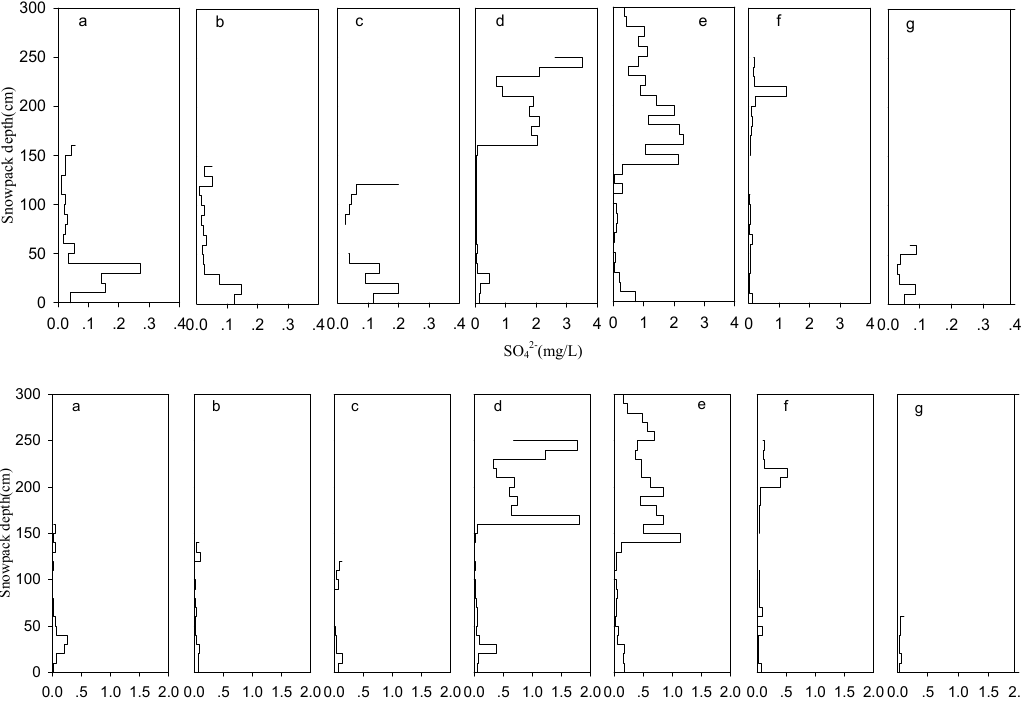
Figure 3. The vertical variation of ionic concentrations for snow profiles sampled in ( a ) November, ( b ) December, ( c ) January, ( d ) March, ( e ) April, ( f ) June, and ( g ) July.